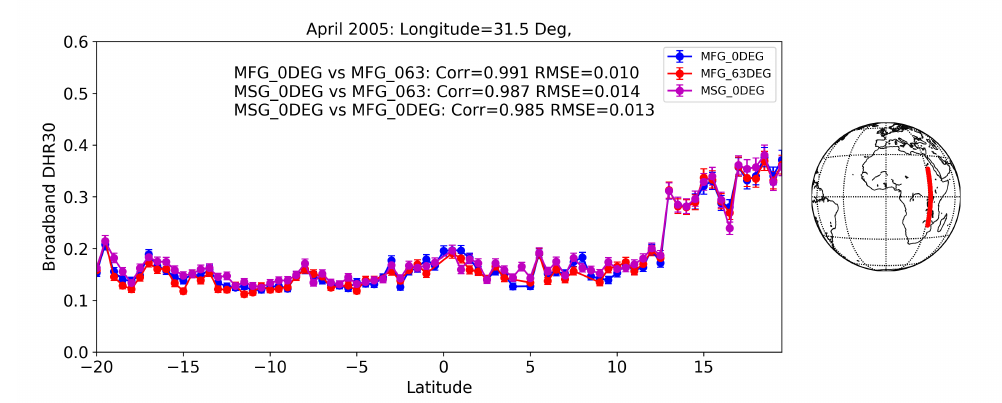
Figure 5. Comparison between the broadband DHR30 retrieved along a longitudinal transect from